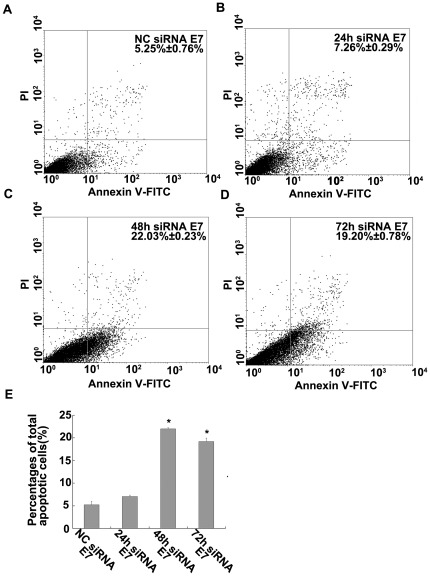
Transfection with E7-siRNA induced apoptosis.(A, B, C and D) The percent of apoptotic Hep G2 cells was measured using the Annexin V assay at 24 h, 48 h and 72 h after transfection, and then the stained cells were analyzed through flow cytometry. (E) The results showed that 7.26%±0.29%, 22.03%±0.23% and 19.20%±0.78% in siRNA E7 transfected Hep G2 cells after 24 h, 48 h and 72 h underwent total apoptosis compared with only 5.25%±0.76% in NC siRNA E7 transfected cells (p<0.05).